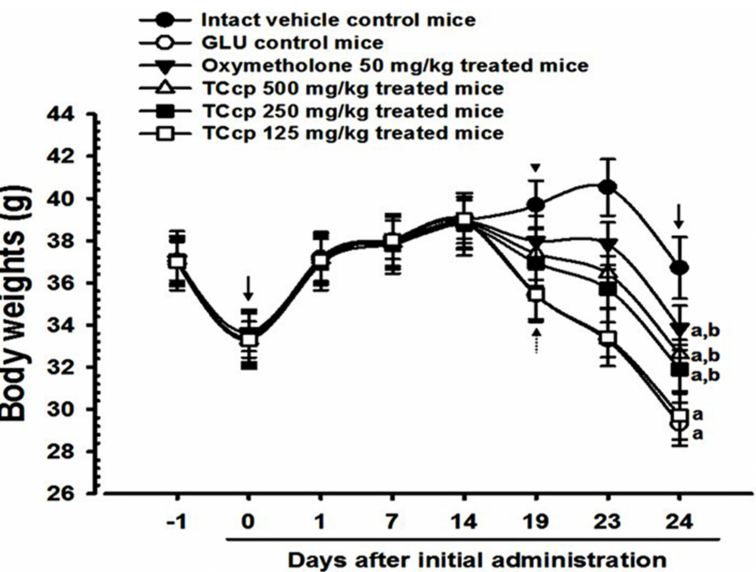
Figure 1. Changes in body weight in GLU-induced muscular atrophic mice. Values are expressed means ± S.D. of eight mice. Dot arrows show significant decreases in body weights in GLU control mice after 5 days of initial DEXA treatment to sacrifice. However, these decreases in body weights were significantly inhibited by treatments with oxymetholone and TCcp (500 and 250 mg/kg) (arrow- head). Day-1 and Day-24 means 1 day before starting the test material administration and at sacrifice, respectively. Day 0 means at start of test material administration (2 weeks before initial DEXA treatment). All animals were overnight fasted before first test material administration and sacrifice (arrows). TCcp = tart cherry concentrated powder. GLU = glucocorticoid. DEXA = dexamethasone. a p < 0.01 as compared with intact control by LSD test. b p < 0.01 as compared with GLU control by LSD